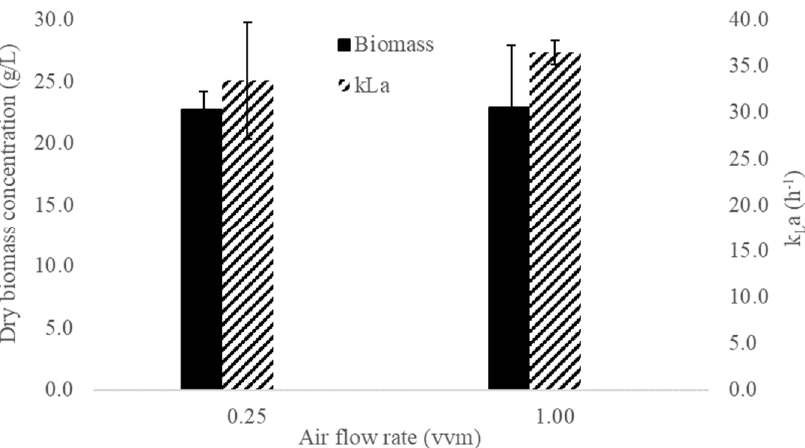
Figure 5. Dry biomass concentration (at 12 days) and k L a (before inoculation) for the two airflow rates tested at the stirred tank bioreactor. Error bars indicate the standard deviation of two independent replicates.